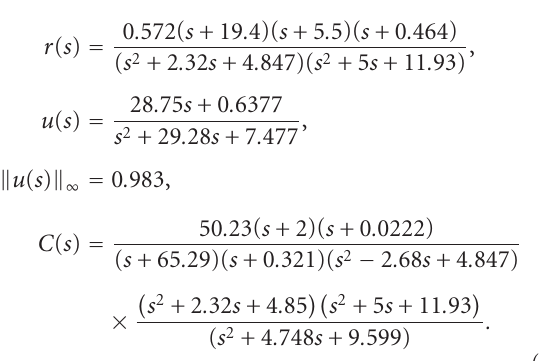
For ε 1 = 3 . 3, the results are